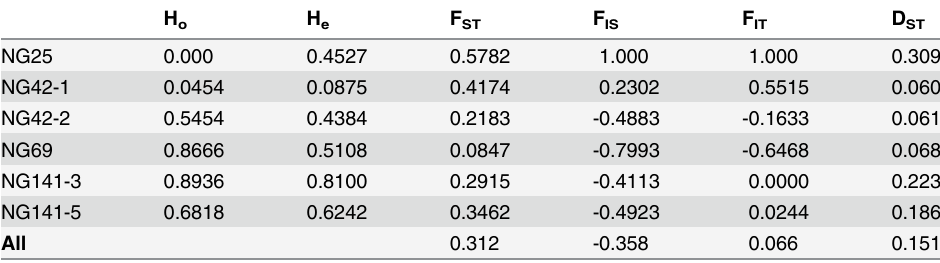
PLOS ONE | DOI:10.1371/journal.pone.0152434 April 1,